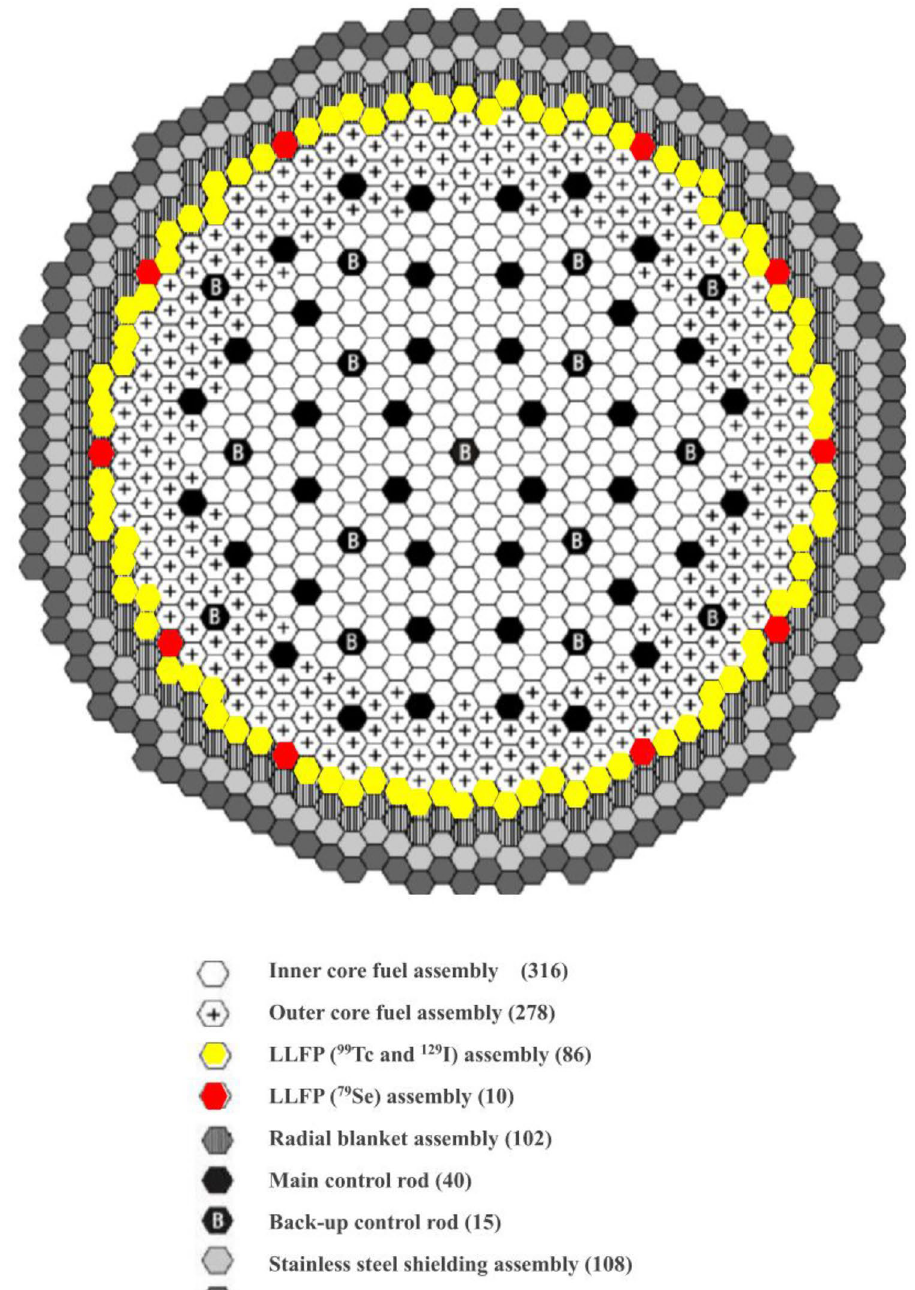
Figure 2. Core arrangement for MA and LLFP transmutation in a fast breeder reactor. The core has two homogeneous zones: inner and outer cores. MA fuel assemblies are loaded in the inner and outer cores. The LLFP assemblies are loaded in the first layer of the blanket region. The blanket fuel assemblies are loaded in the second layer of the blanket